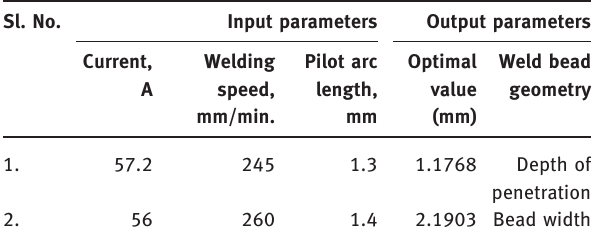
Table 10: Results of BPNN-GA optimization. Sl. No.